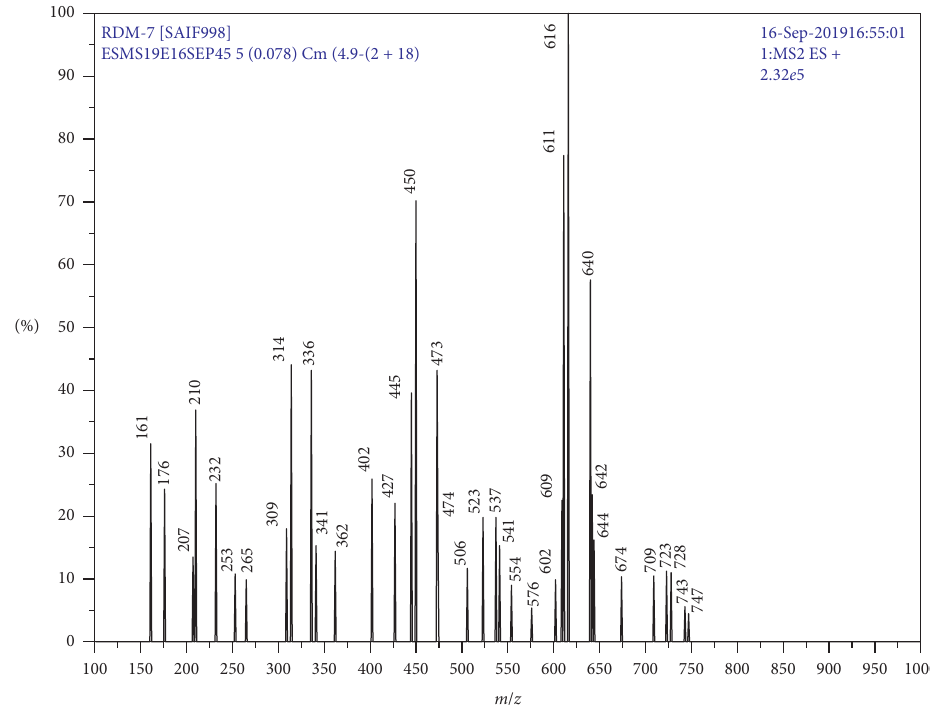
Figure 3: ESI-MS spectrum of the Mo-OTC/Sal